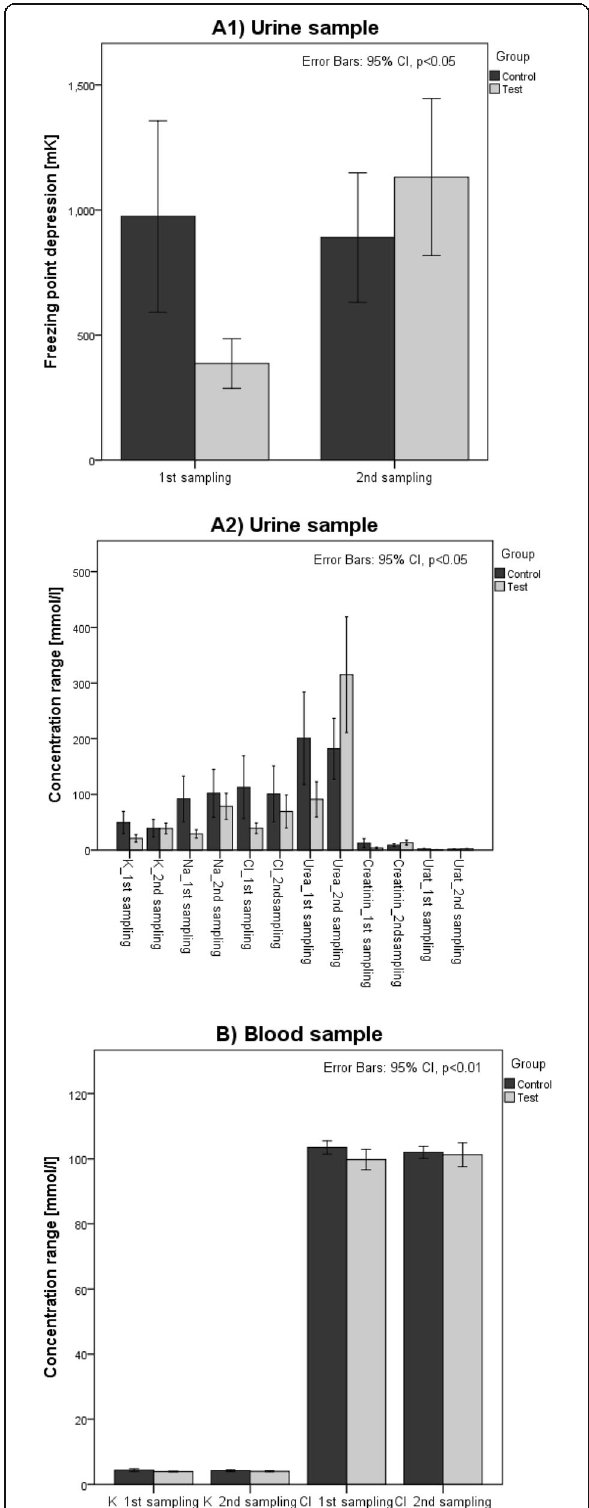
Fig. 1 Differences between test and control group in urine ( A1 , A2 ) and blood ( B )